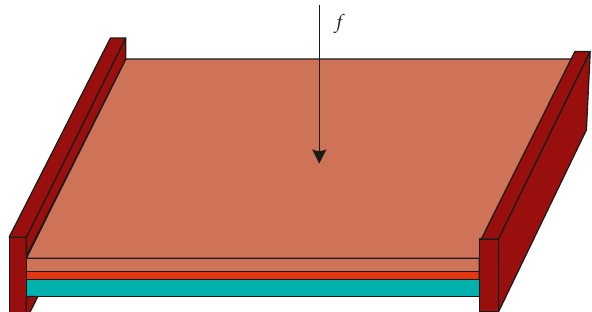
Figure 7: The plate/CLD system with two short edges clamped.